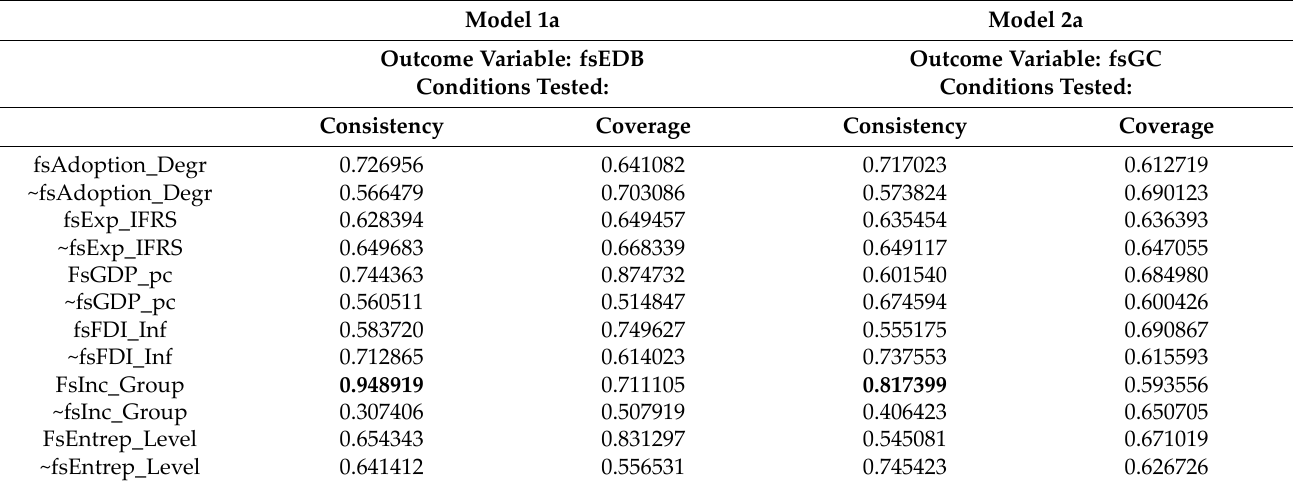
Table 6. Analysis of necessary conditions (Model 1a and Model 2a).